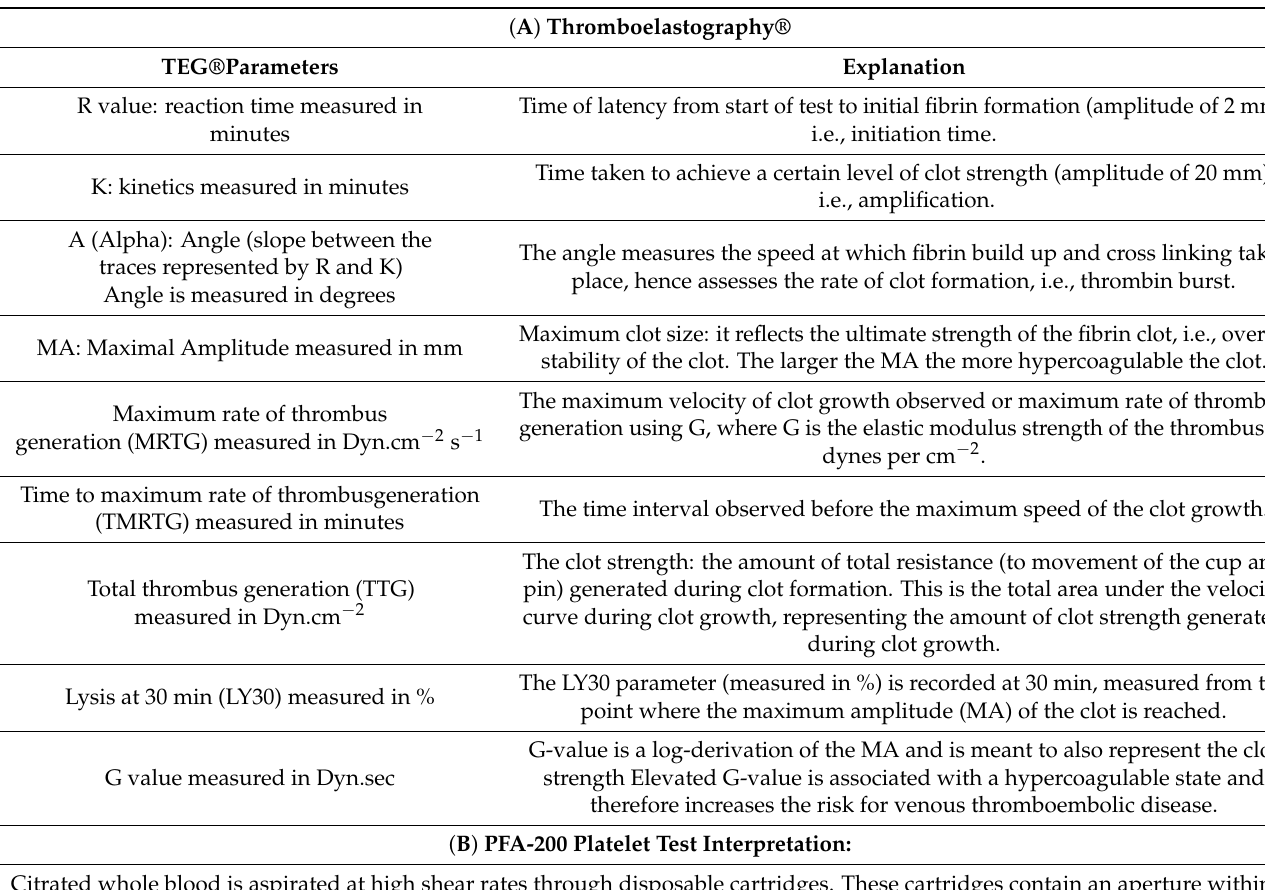
Table 2. ( A ) Thromboelastography ® (TEG ® ) clot parameters for whole blood and ( B ) PFA-200 platelet